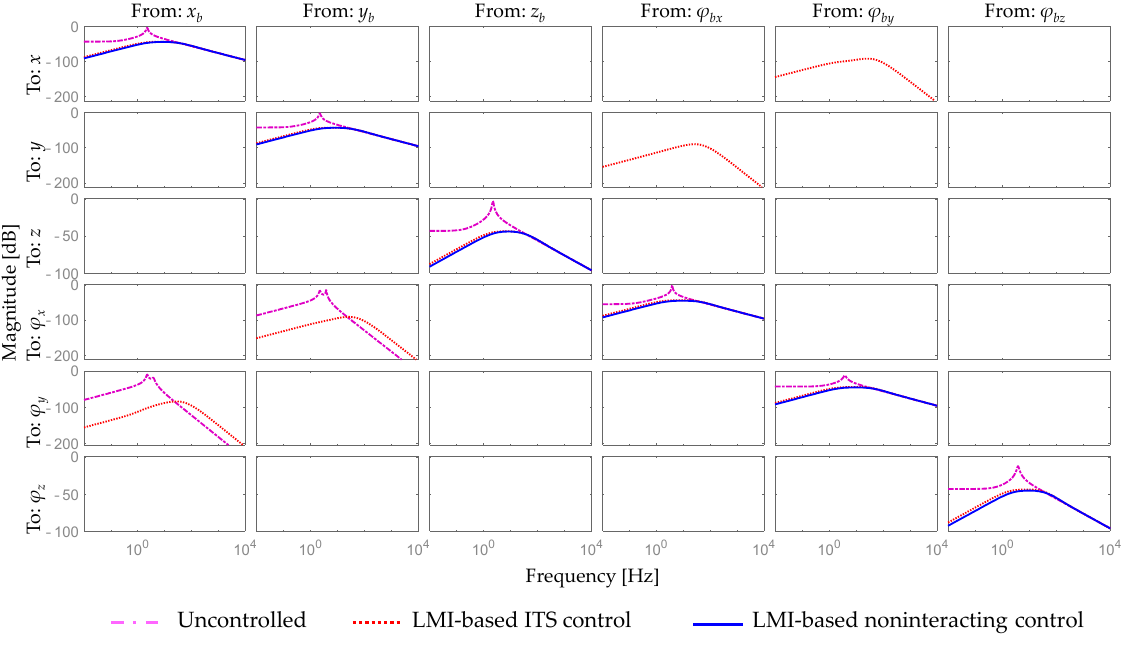
Figure 3. Frequency response of the vibration isolation performance.